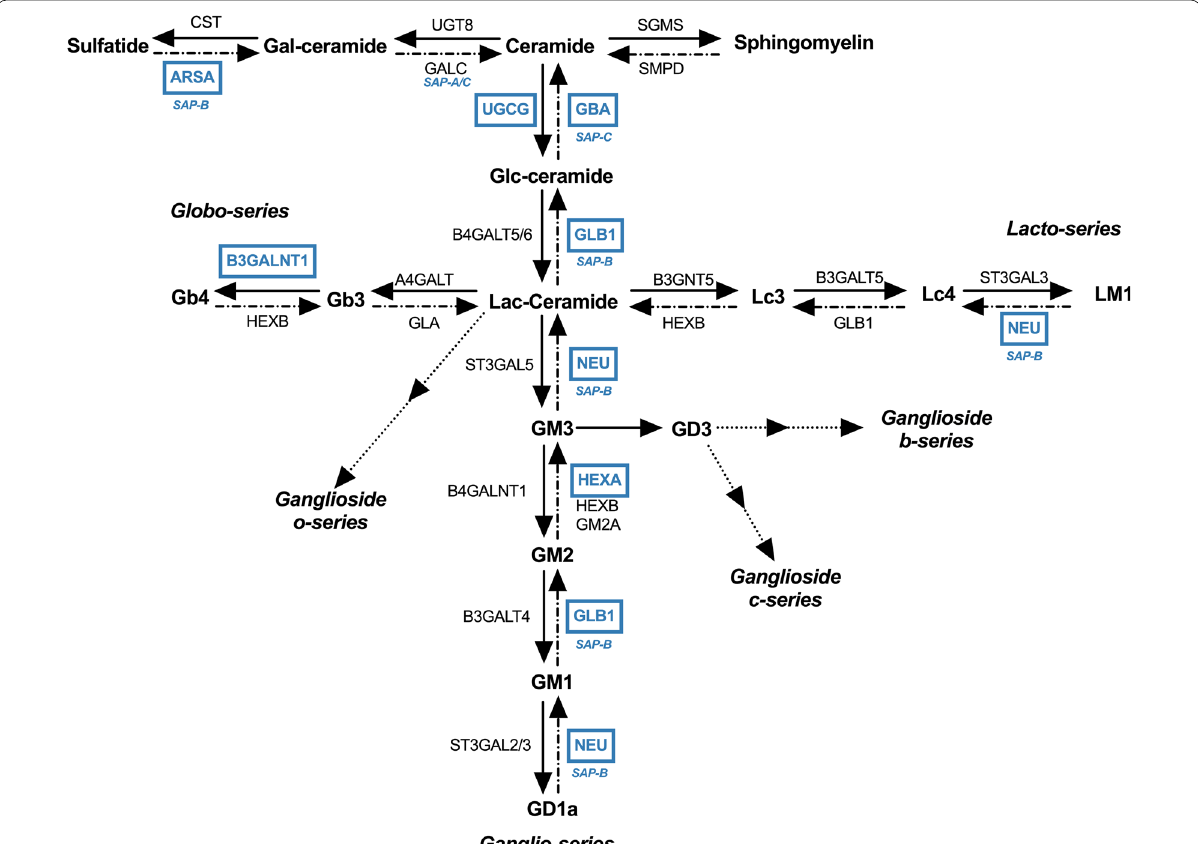
Fig. 6 Schematic representation indicating sphingolipid metabolism genes downregulated in THRSP‑silenced adipocytes. The figure represents sphingolipid metabolism, where the altered genes are designated by blue color. Saposin (SAP) below the gene name indicates activation by SAPs. GalCeramide, galactosylceramide; GlcCeramide, galactorylceramide; LacCeramide, lactosylceramide, CST, cystatin; ARSA, arylsulfatase A; SAP, saposin; UGT8, UDP glycosyltransferase 8; GALC, galactosylceramidase; SGMS, sphingomyelin synthase; SMDP, Sphingomyelin phosphodiesterase; UGCG, UDP‑glucose ceramide glucosyltransferase; GBA, glucosylceramidase beta; B4GALT5/6, beta‑1,4‑galactosyltransferase 5/6; GLB1, galactosidase beta 1; B3GNT5, beta‑1,3‑N‑acetylglucosaminyltransferase 5; B3GALT5, beta‑1,3‑galactosyltransferase 5; ST3GAL3, ST3 beta‑galactoside alpha‑2,3‑sialyltransferase 3; NEU, neuraminidase; HEXB, hexosaminidase subunit beta; HEXA, hexosaminidase subunit alpha; GM2A, GM2 ganglioside activator; ST3GAL2/3, ST3 beta‑galactoside alpha‑2,3‑sialyltransferase 2/3; B3GALT4, beta‑1,3‑galactosyltransferase 4; B4GALNT1, beta‑1,4‑N‑acetyl‑galactosaminyltransferase 1; ST3GALT5, ST3 beta‑galactoside alpha‑2,3‑sialyltransferase 5; GLA, galactosidase alpha; B3GALNT1, beta‑1,3‑N‑acetylgalactosaminyltransferase 1; A4GALT, alpha